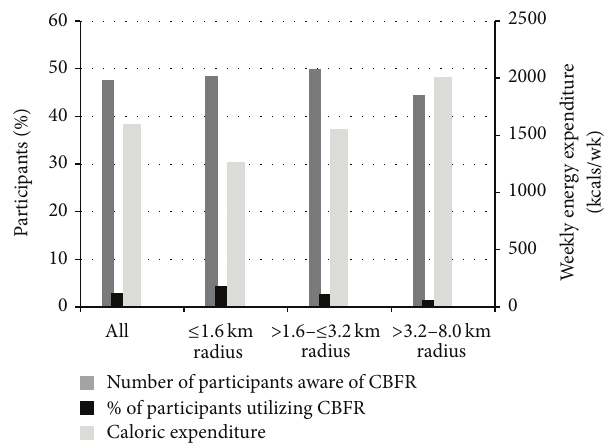
Figure 2: Awareness and utilization of community-based fitness resources (CBFR) compared to weekly energy expenditure (mean ±